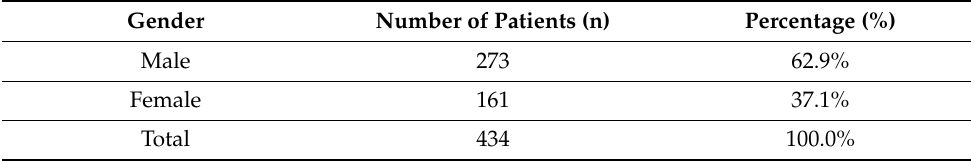
Table 3. Distribution of DFI patients by gender.